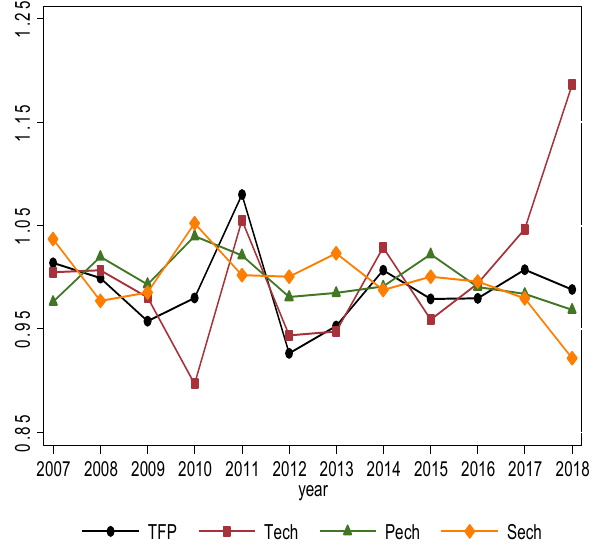
Figure 4. Trends in Production Efficiency of Early Indica Rice from 2007 to 2018.